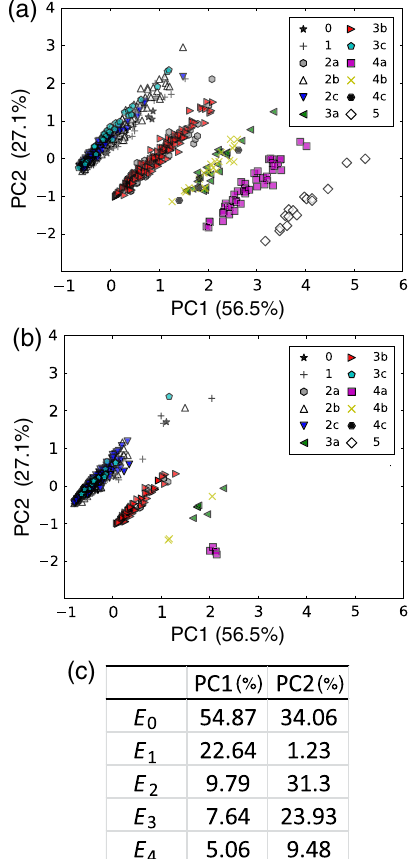
FIG. 9. Principal component biplots. The first two principal components for (a) mobile and (b) nonmobile spins at 25 . 3 °C. The percentages of explained variations for the first two principal components are 56.5% and 27.1%, respectively. They are higher than the mean value of 20%, reflecting a greater contribution to the spin dynamics. Symbols represent different motifs. The cluster distribution results from the discrete energy of motifs. (c) The percentage contribution of the five features E 0 ; … ; E 4 . The percentages are calculated from e 2 for the first two principal i components, where e is the component corresponding to the i th i feature of the first and second principal